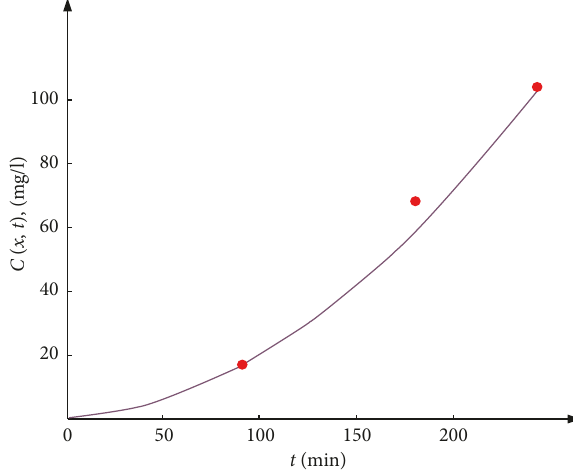
Figure 2: Distribution of the concentration of divalent iron over time at the exit of the coagulator.